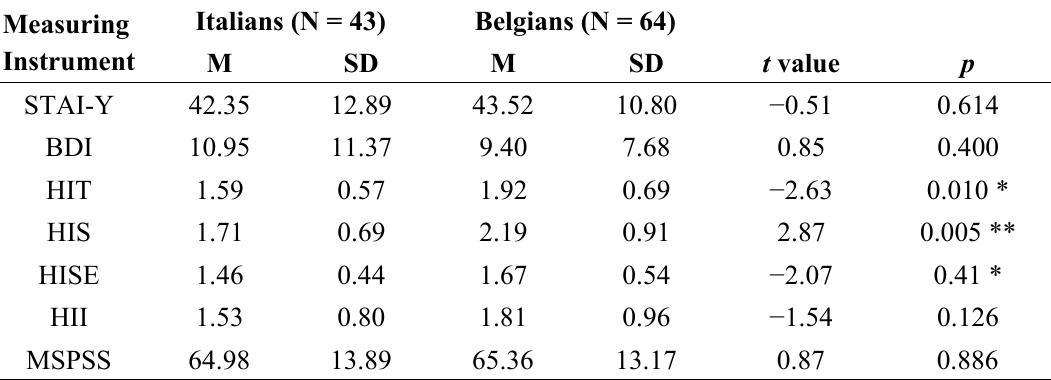
Table 3. Mean, standard deviation, t value and p value comparing Italian and Belgian gay men’s